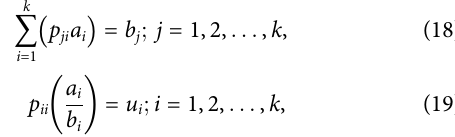
Frontiers in Environmental Science |